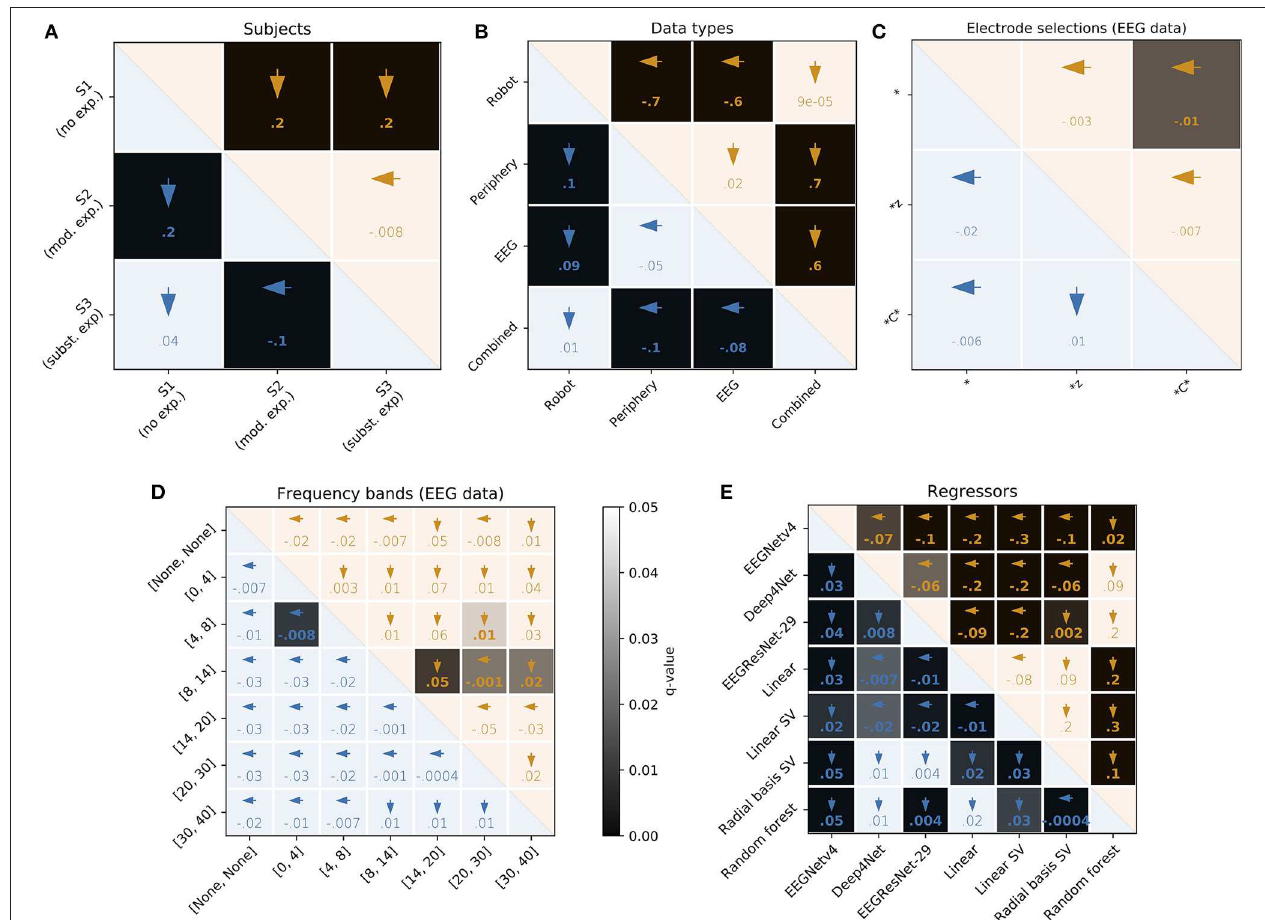
FIGURE 8 | User, feature, and regressor overview. Each matrix is based on the results of the 924 test-set regressions (3 users · 44 features · 7 models), split according to visualized parameter. Numbers in the lower and upper triangles of each comparison matrix are the differences between median RMSE (blue) and Pearson’s ρ (orange), respectively. Bold font indicates q < 0.05. Arrows indicate the parameter with better performance of each pair. The gray-scale background of each cell codes for the corresponding q -value. Separate FDR corrections for each triangle of each matrix. (A) Users: FDR-correction for 3 tests. mod., moderate; subst., substantial; exp., experience. (B) Data types: FDR-correction for six tests. (C) Electrodes. FDR-correction for 3 tests. *All EEG electrodes, *z: midline electrodes, *C*: sensorimotor cortex electrodes. (D) Frequency bands: FDR-correction for 21 tests. The corner frequencies of band-pass filters used are indicated in the square brackets. (E) Regressor: FDR-correction for 21 tests. SV, support